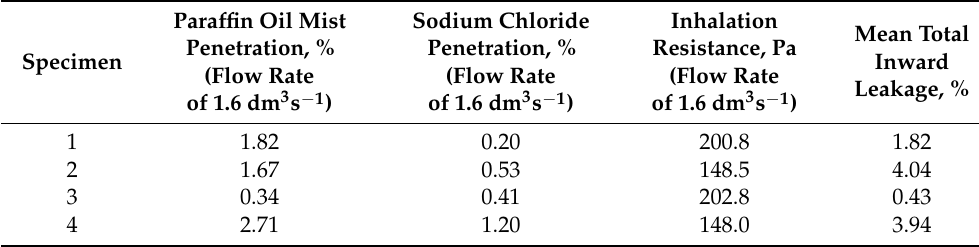
Table 2. Protective and functional parameters of half-masks with carbon sorbents.